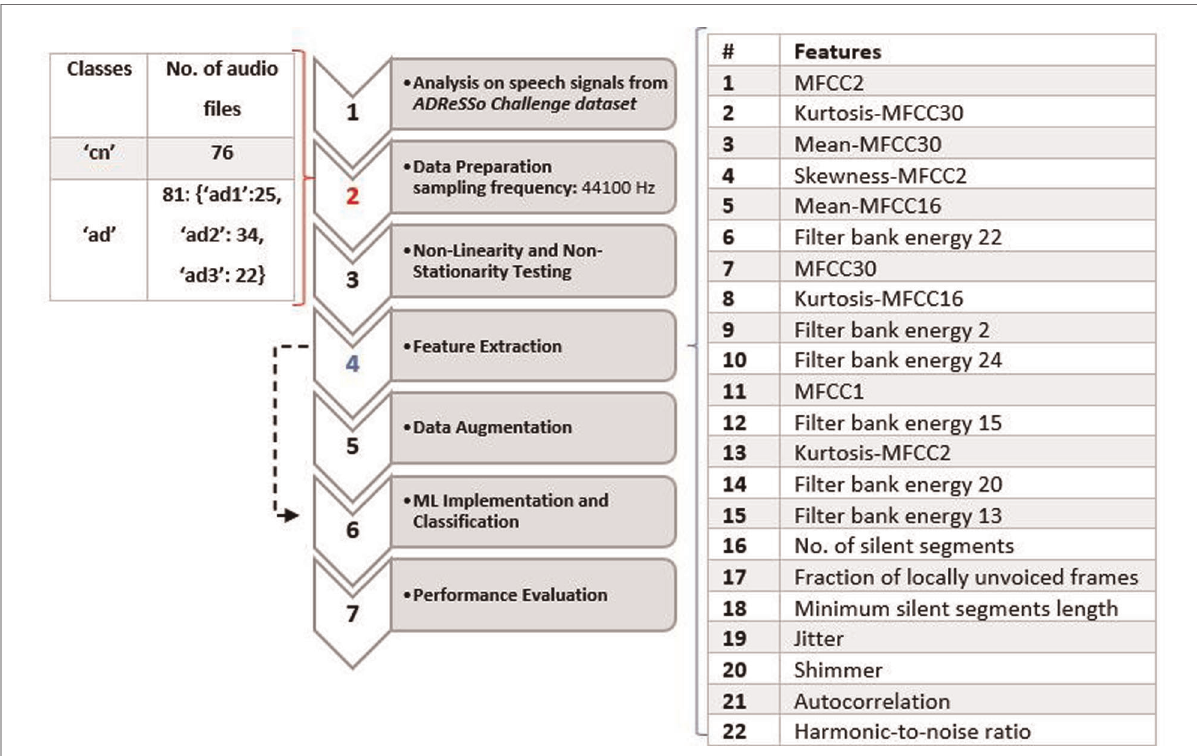
FIGURE 1 Flowchart diagram of the proposed system with list of features used and dataset